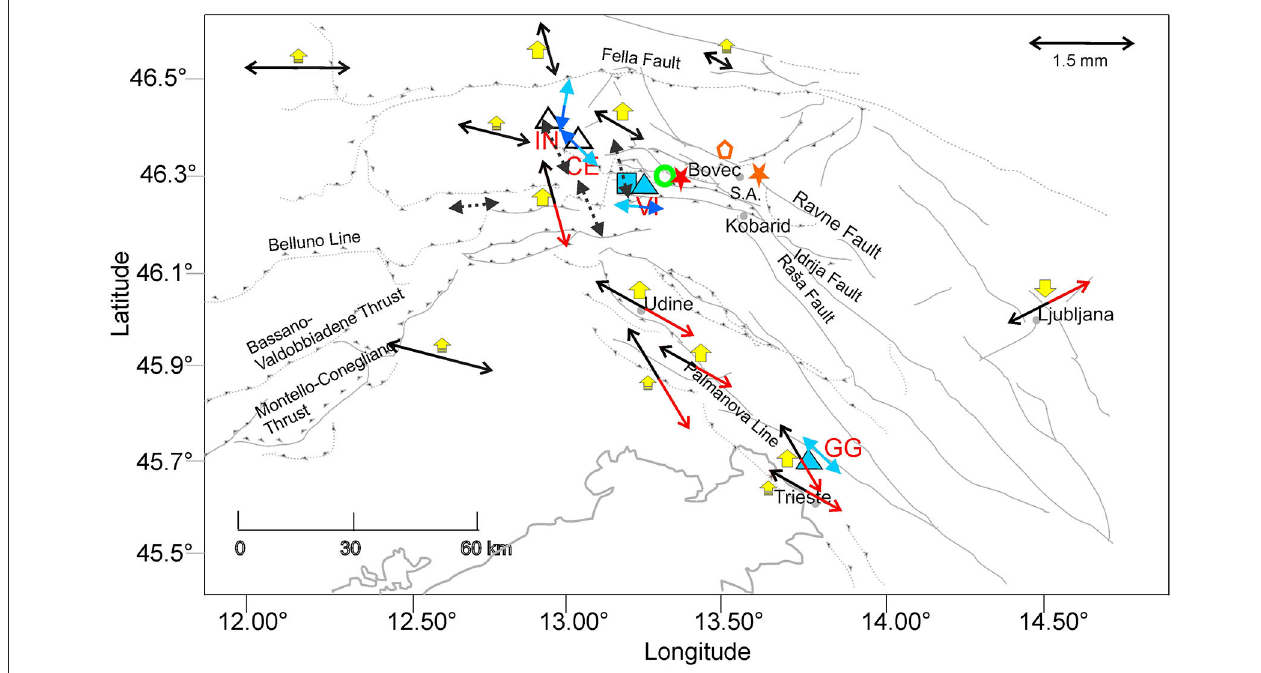
FIGURE 7 | The same map as Figure 3 , with indication of the directions of the transient 1984–1990 tilting (blue arrows), of the 2006–2009 GNSS transient displacement (RossiII, red-black arrows, yellow arrows), and of the alignment of the background seismicity (Bressan et al., 2016): gray dashed arrows. 1984–1990 tilting- the map refers to the end of 1985: blue color indicates the positive tilting verse, whereas light blue indicates the negative tilting. A light blue two-sided arrow indicates null tilting. 2006–2009 GNSS displacement- the map refers to June 2008: the red-black arrows indicate the direction of horizontal displacement, red for the positive verse of the displacement, whereas black is the negative displacement. A two-sided black arrow means null horizontal displacement. The vertical displacement is represented by the yellow arrows, indicating up or down movement: if the maximum was not reached in June 2008, the arrow is smaller. Green circle: the origin of the transient analyzed in this study, orange pentagon is the source of the transient analyzed by RossiI and RossiII; red star: 1983, M D = 4.2 Uccea earthquake, 10.8km depth; orange star: 2004, M w = 5.1 Bovec–Krn earthquake; 6.1km depth. SA, South Alpine thrust.